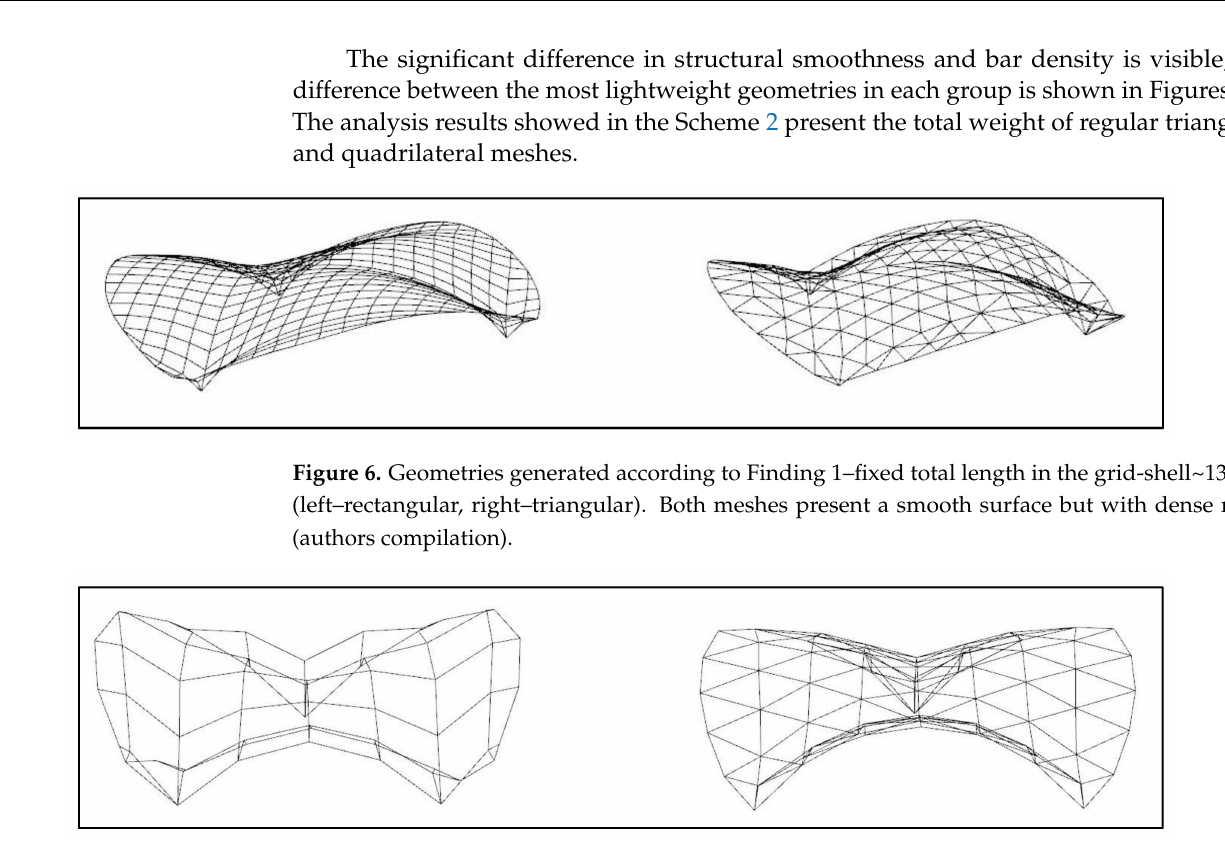
Figure 7. Geometries generated according to Finding 2–fixed length of each bar~5 m (left–rectangular, right–triangular). The quadrilateral mesh lacks surface smoothness (authors compilation).